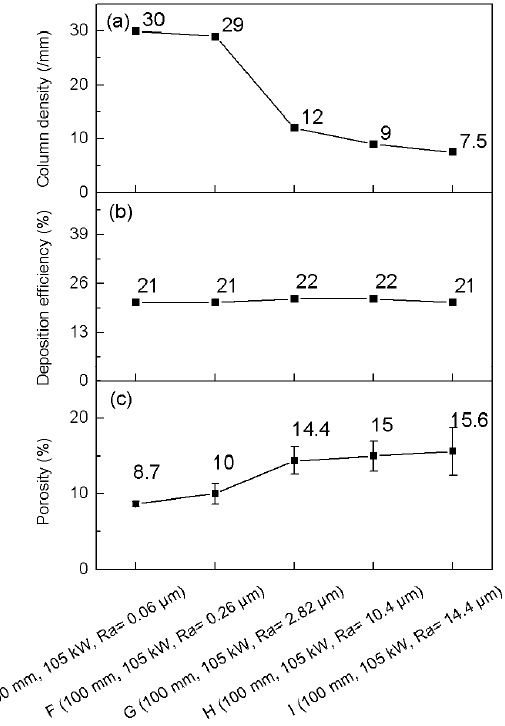
Figure 4. Column density ( a ), deposition efficiency ( b ) porosity ( c ) for as sprayed YSZ top coats (Samples E–I) deposited with 100 mm standoff distance on BC with different surface treatments.